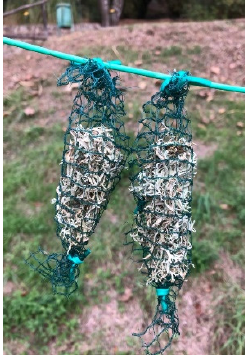
Figure 1. Lichen bags of Evernia prunastri exposed in the Botanical Garden of the University of Siena.